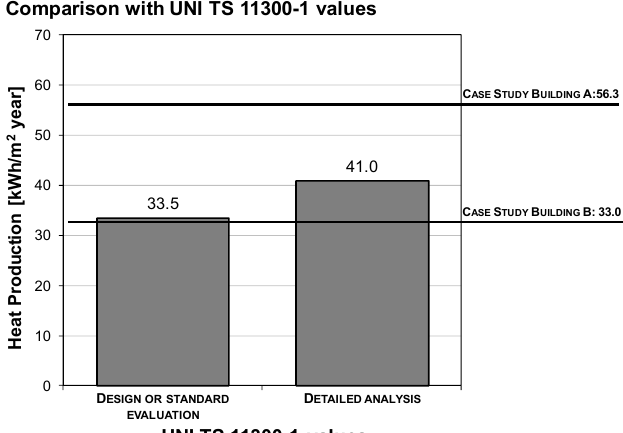
Figure 7. Comparison of the yearly internal heat production for Buildings A and B calculated by TRNSYS and the data from UNI TS 11300-1 [32], in kW h/m 2